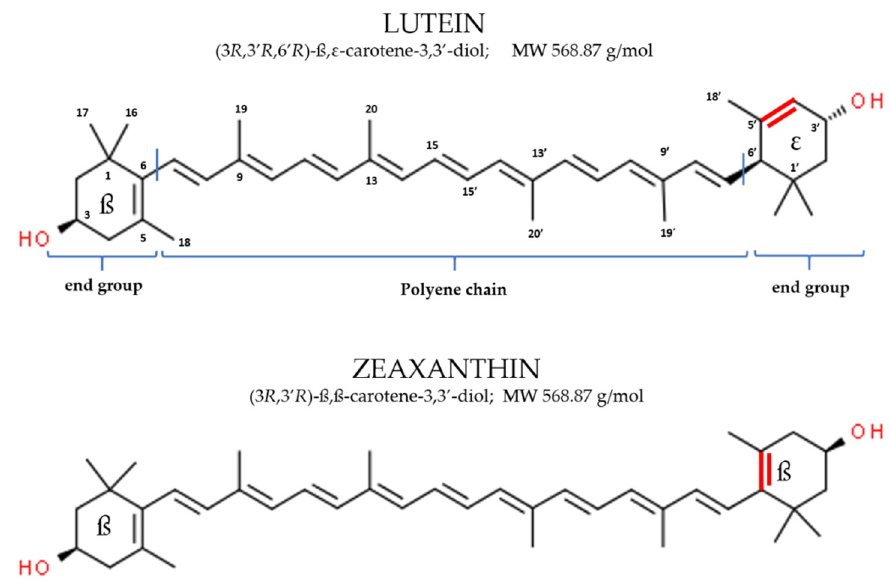
Figure 4. Chemical structure of dietary lutein and zeaxanthin.